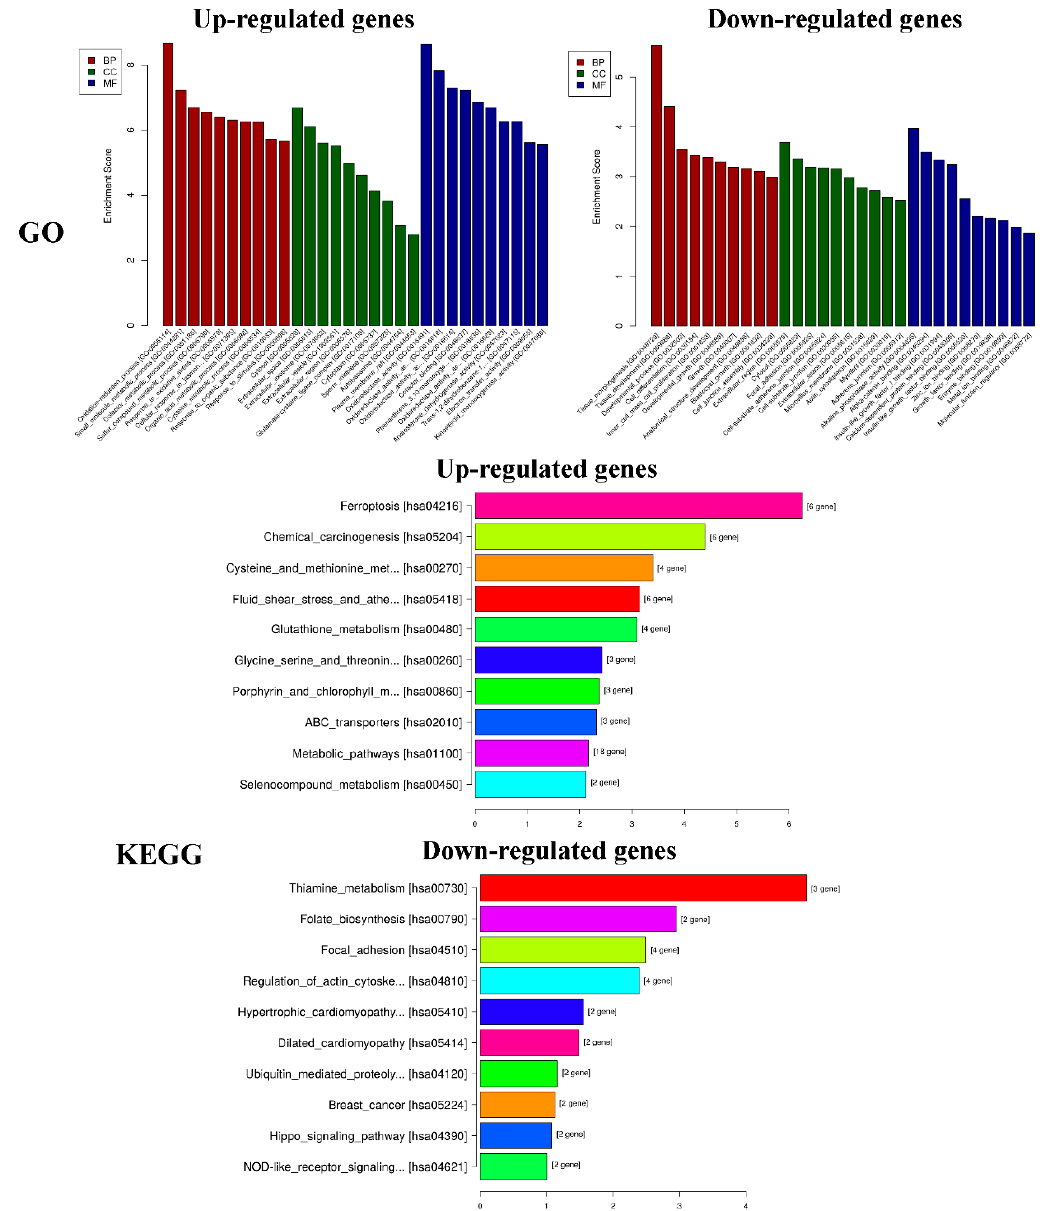
Figure 9. Results of functional and pathway enrichment analyses. GO: Gene ontology, KEGG: Kyoto encyclopedia of genes and genomes.